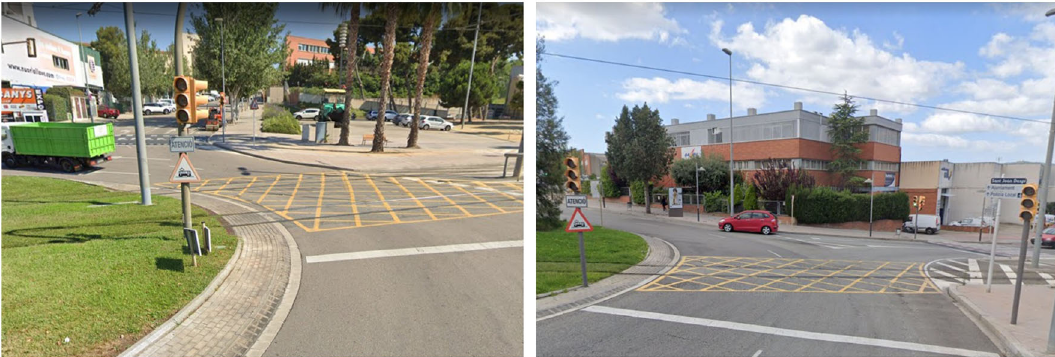
Fig. 5 Road carriageway near an intersection with a tramway line (Spain) - source from Google Earth (data provider: (cid:2) 2020 Google)